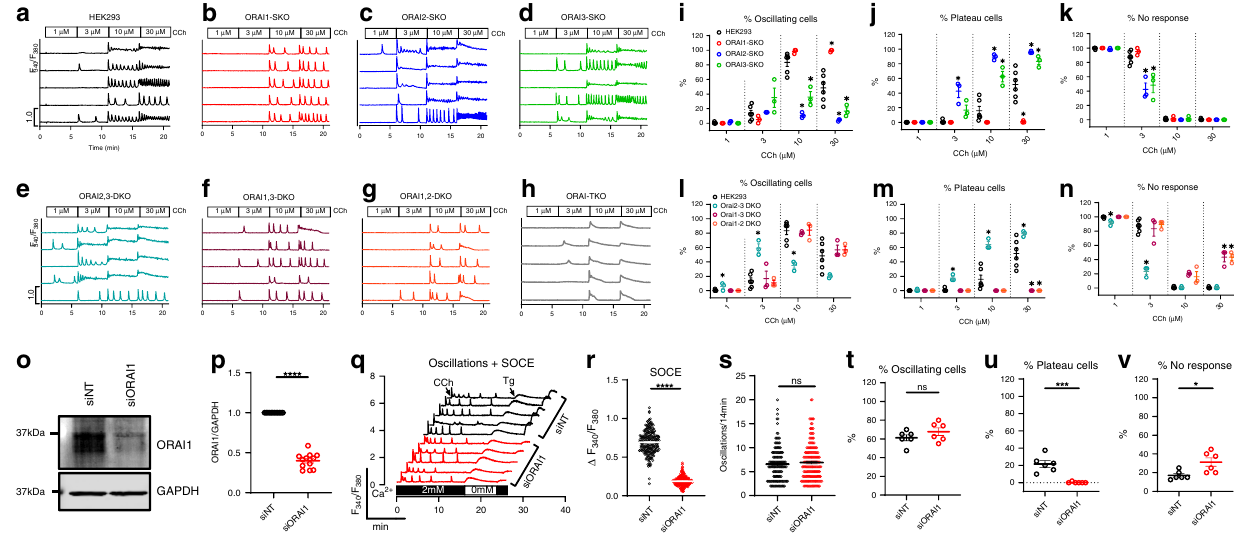
Fig. 2 ORAI3 and ORAI2 are required for Ca 2 + oscillations. a – h Representative Ca 2 + oscillations in response to increasing concentrations of carbachol (1 – 30 µ M Cch) measured using Fura2 in parental HEK293 cells, and in single, double, and triple ORAI knockout cells. Cells were maintained in HBSS containing 2 mM Ca 2 + for the duration of the experiments and stimulated with 1, 3, 10, and 30 µ M Cch for a duration of 5 min each. Representative traces were chosen from fi ve cells/condition to represent the datasets as a whole. i – n Quanti fi cation of % of oscillating cells ( i , l ), % of plateau cells ( j , m ), and % of non-responding cells ( k , n ) for conditions from a – h (for i – k and l – n , n = 6, 3, 3, and 3 from left to right; each point represents an independent experiment). Quanti fi cation of oscillation data was performed using one-way ANOVA with multiple comparisons to WT HEK293 cells (* p < 0.05). o Representative Western blot documenting ORAI1 protein knockdown with siRNA in WT HEK293 cells. p Quanti fi cation of ORAI1 protein knockdown using ORAI1/GAPDH densitometry. Each data point represents a technical replicate from four independent knockdown experiments ( n = 12). q Representative Ca 2 + oscillations in response to 10 µ M carbachol (Cch) followed by measurements of SOCE elicited by subsequent addition of 2 µ M thapsigargin in HEK293 cells transfected with siRNA against ORAI1 (siORAI1) and non-targeting control siRNA (siNT). r Quanti fi cation of the magnitude of SOCE in siNT- and siORAI1-transfected cells ( n = 240 for siNT and 256 for siORAI1; each point represents an individual cell). s – v Quanti fi cation of total oscillations/14 min ( s ), % of oscillating cells( n = 144 for siNT and 182 for siORAI1; each point represents an individual cell) ( t ), % of plateau cells ( u ), and % of non-responding cells ( v ) in siNT- and siORAI1-transfected cells (for t – v , n = 6 for both siNT and siORAI1; each point represents an independent experiment). All siRNA scatter plots, which represent the mean ± SEM were analyzed using the Mann – Whitney U -test (* p < 0.05; *** p < 0.001; **** p < 0.0001; ns, not signi fi